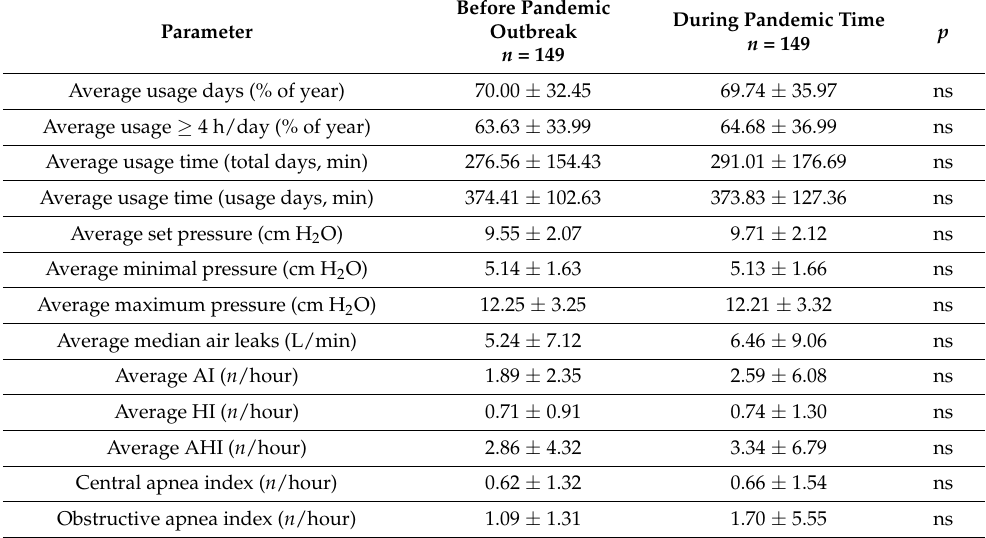
Table 1. CPAP therapy parameters and therapy adherence of study group before pandemic outbreak and during first year of pandemic